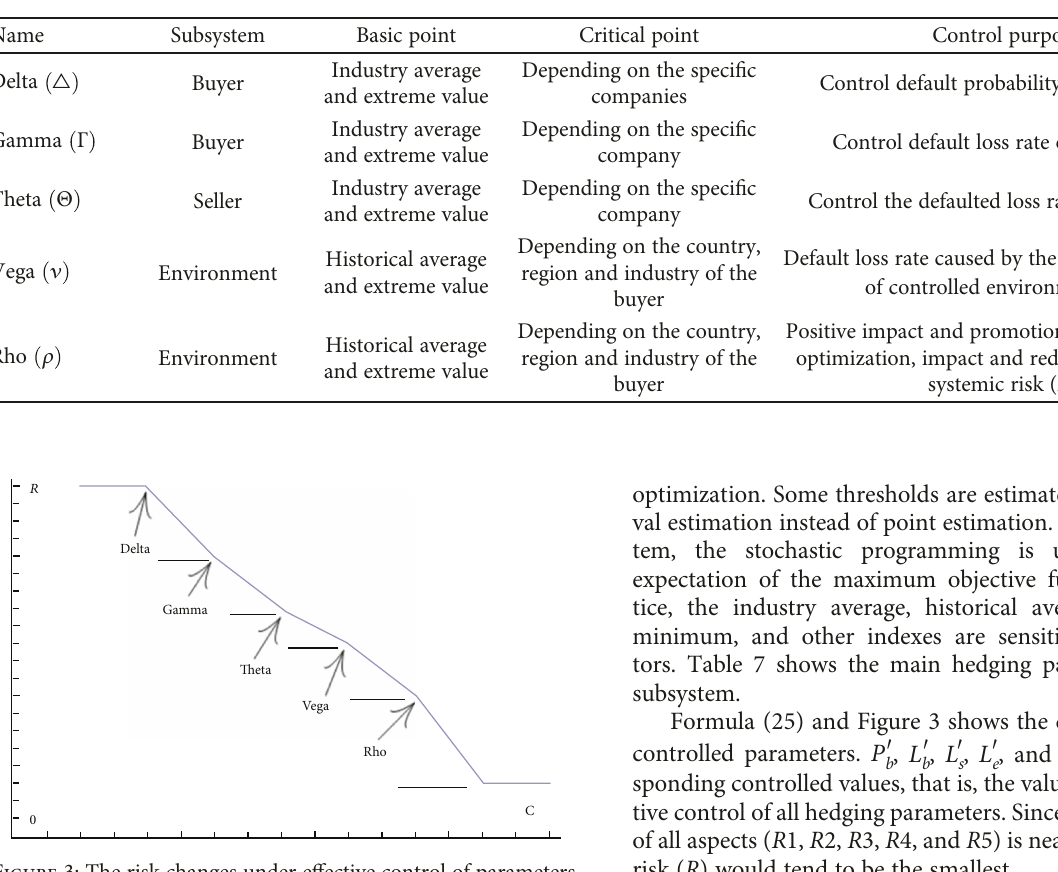
Table 7: The main hedging parameters of subsystems.